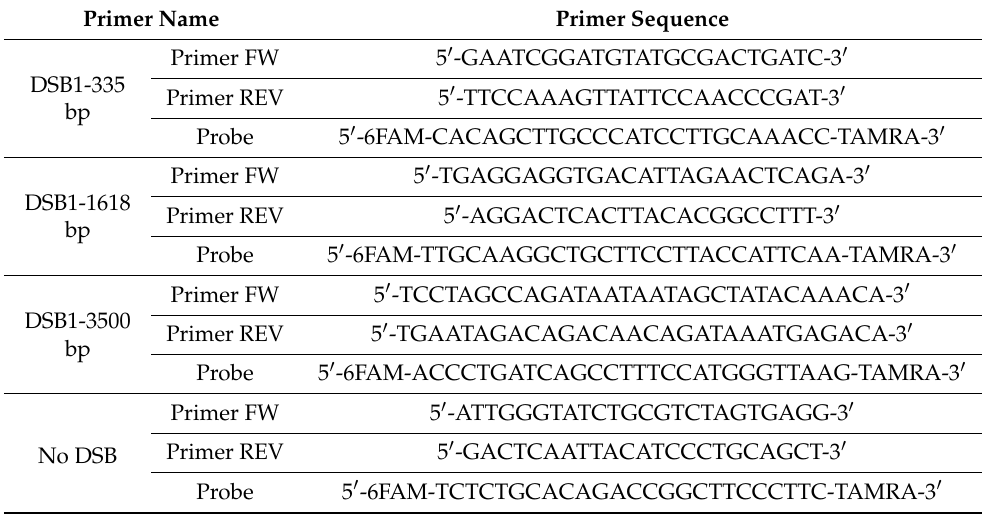
Table 2. A list of the primers and probes used in this